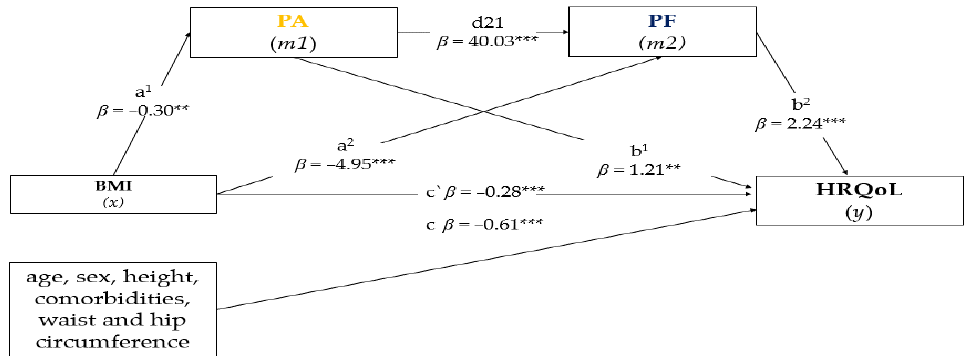
Figure 1. Analysis of parallel mediation of the effects of body mass index (BMI) on health-related quality of life (HRQoL) through physical activity (PA) and physical function (PF). The analysis was based on 5000 bootstrap samples. Results of the simultaneous regression analyses were presented by beta values ( β ), using the bootstrap method with bias correction for 5000 samples, followed by confidence intervals (95%). Path a 1 and a 2 = association of the BMI with PA and PF, respectively; Path d21 = association between PA and PF mediators; Path b 1 and b 2 = association of PA and PF mediators with HRQoL, respectively; Path c’ = direct effect (BMI— HRQoL), Path c = indirect effect: association of BMI with HRQoL through PA and PF mediators. ** p < 0.01, *** p < 0.001.